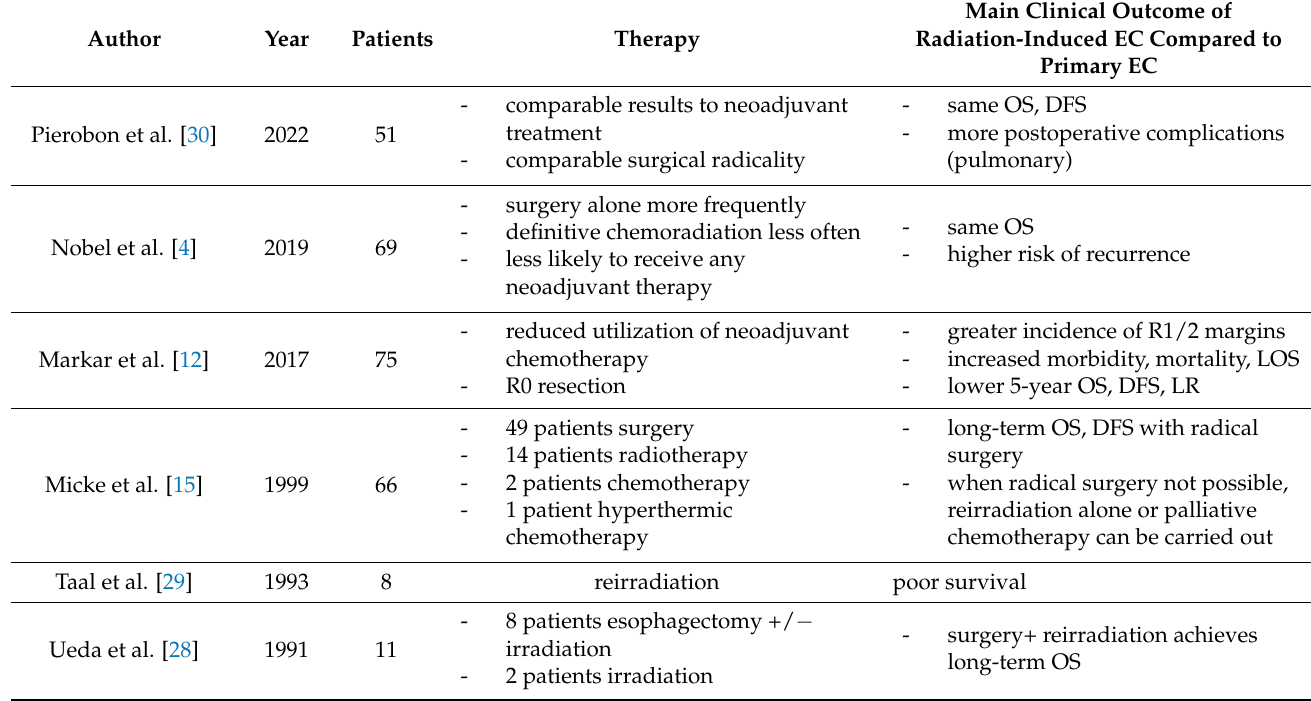
Table 2. Therapeutic options and main clinical outcomes in studies with post-radiation esophageal cancer